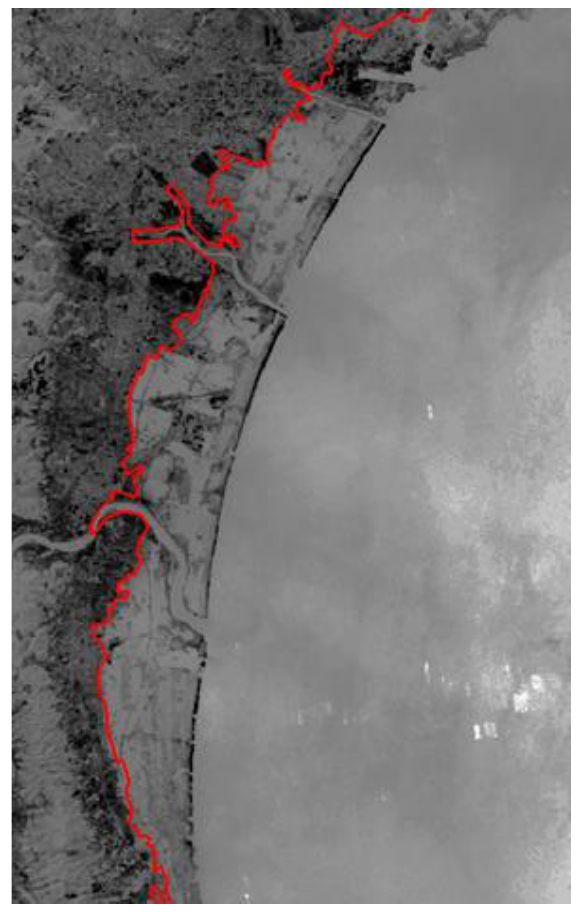
Figure2. Morphological profiles (MPs) 9by9 filter To confirm this procedure, using ALOS/PALSAR, HH, level 1.5 and AVNI-R-2, 4-band data, choosing principal component 2 image and calculating opening and closing procedure in